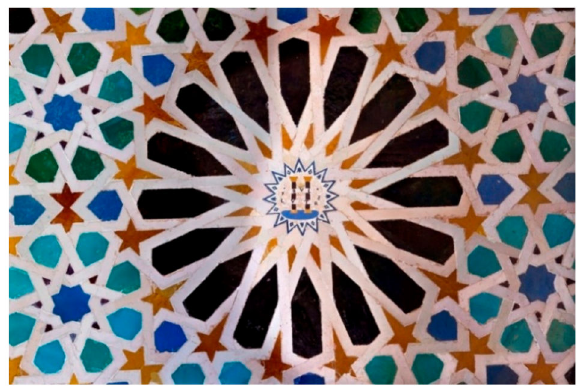
Figure 5. From the outset, there are records of repairs, retouching and other interventions on the glazed ceramics, especially the alicatados , as in the case of this dado in the Mexuar, which features the Plus Ultra symbol from the times of Charles V. © Mar í a Elena D í ez Jorge,